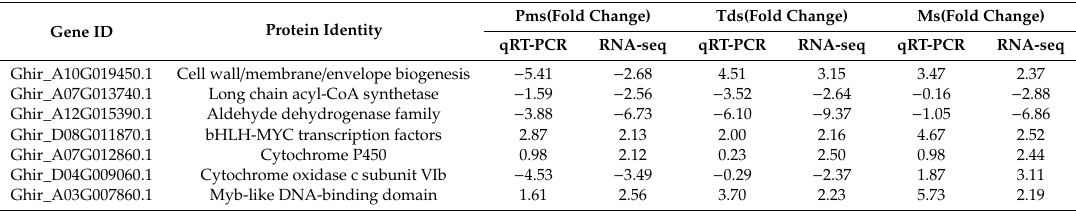
Table 2. qRT-PCR confirmation of DEG expression